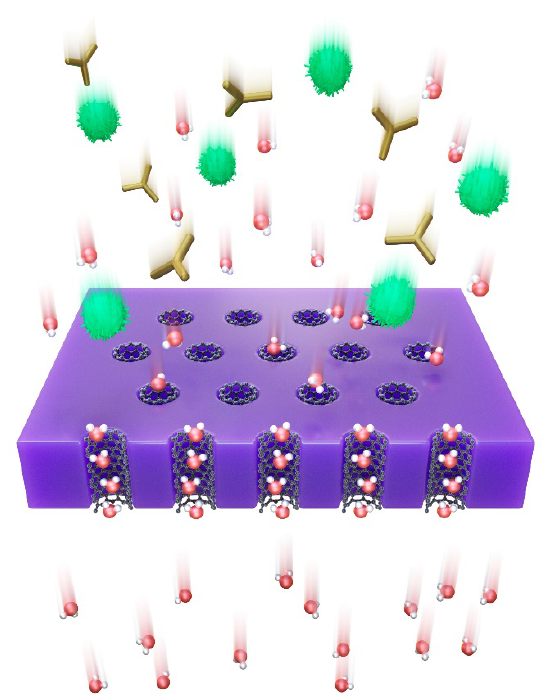
Figure 1. Schematic of a vertically aligned carbon nanotube (VACNT) membrane used for water treatment. The image shows water molecules, unwanted molecules, and an impermeable material filling the interstitial spaces between carbon nanotubes (CNTs) and VACNTs.